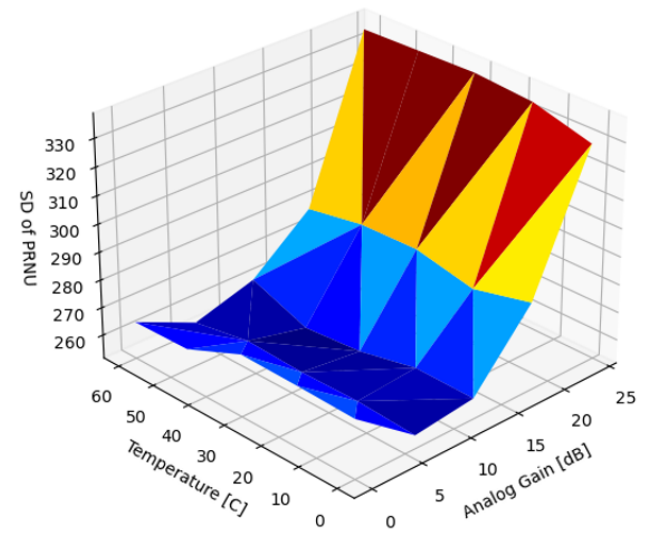
Figure 18. SD of uncorrected PRNU, σ r ( α , T ) .